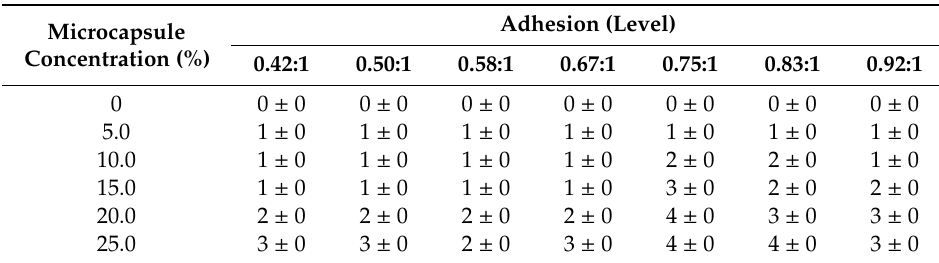
Table 6. E ff ect of the Concentration of Microcapsules with Di ff erent Core–Wall Ratios on the Adhesion of Waterborne Primer Coating.